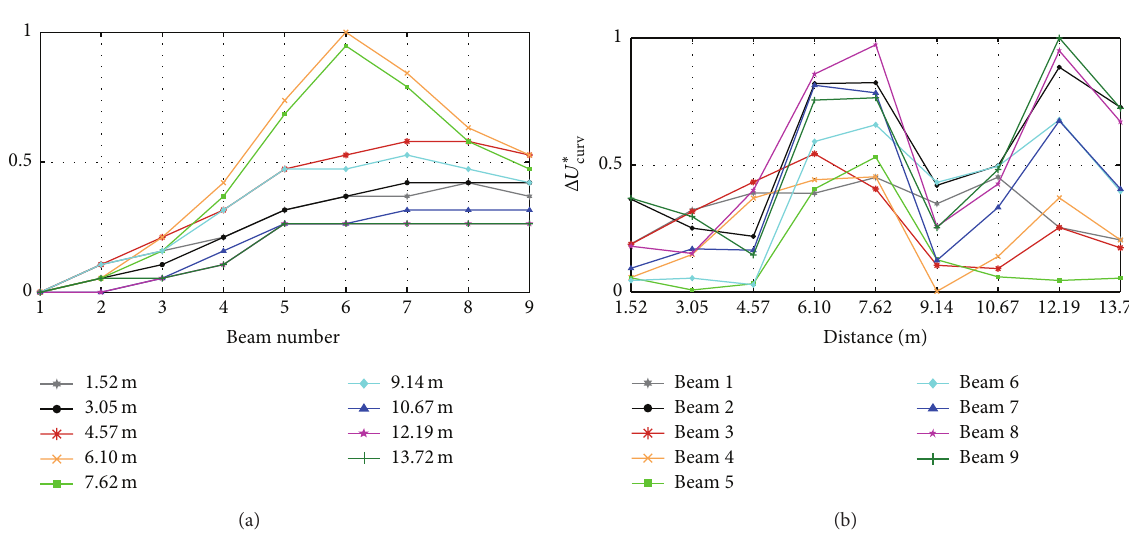
for damage case curv